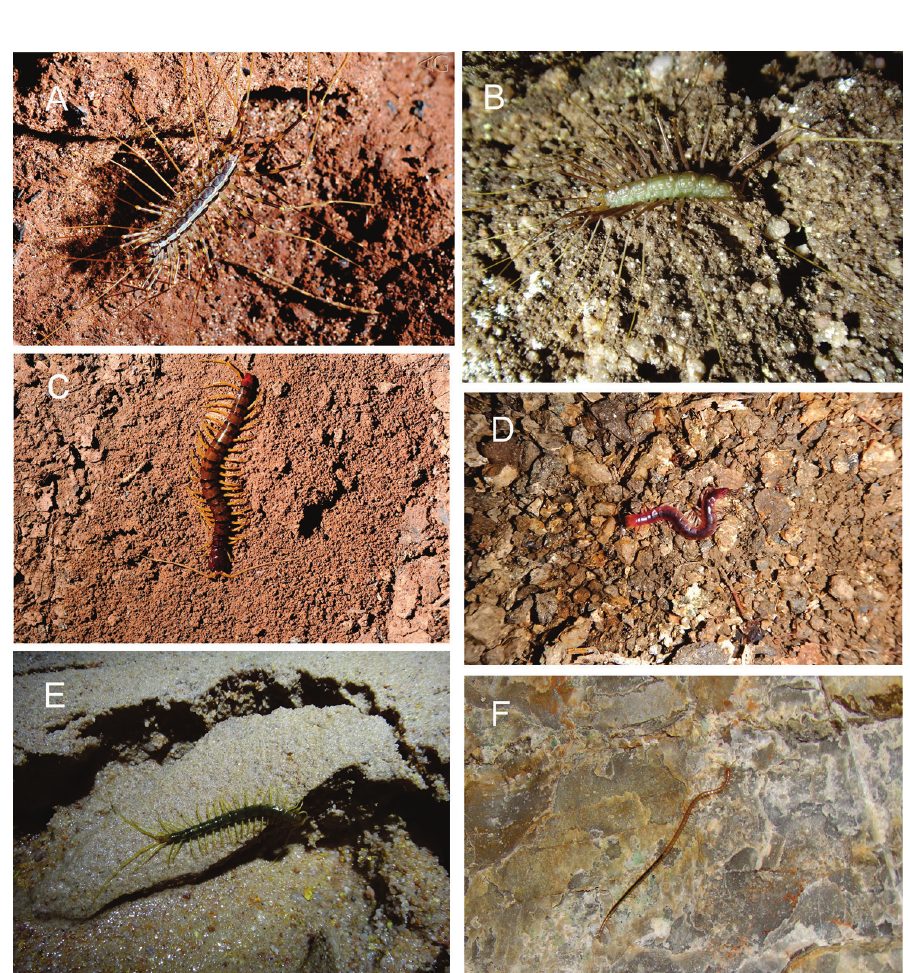
Figure 3. Centipedes from Brazilian caves in loco . A Sphendononema guildingii from limestone caves of Serra do Ramalho, Bahia state (A. Gambarini) B Sphendononema sp. from sandstone caves of Igatu, Chapada Diamantina, Bahia state (E.C. Igual) C Scolopocryptops miersii from limestone caves of Serra do Ramalho, Bahia state (A. Gambarini) D Otostigmus tibialis from granitic caves of Florianópolis, Santa Catarina state (M.E. Bichuette) E Scolopocryptops troglocaudatus from Igatu, Chapada Diamantina, Bahia state (E.C. Igual) F Ribautia sp. from a limestone cave of Peruaçu, Minas Gerais state (P.P.